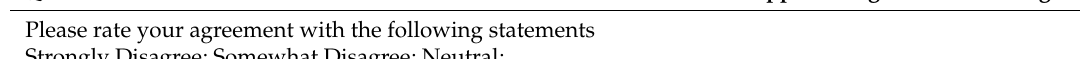
Table 2. Study 1: Test retest reliability of the KAP questionnaire for individual questions. n Kappa Agreement